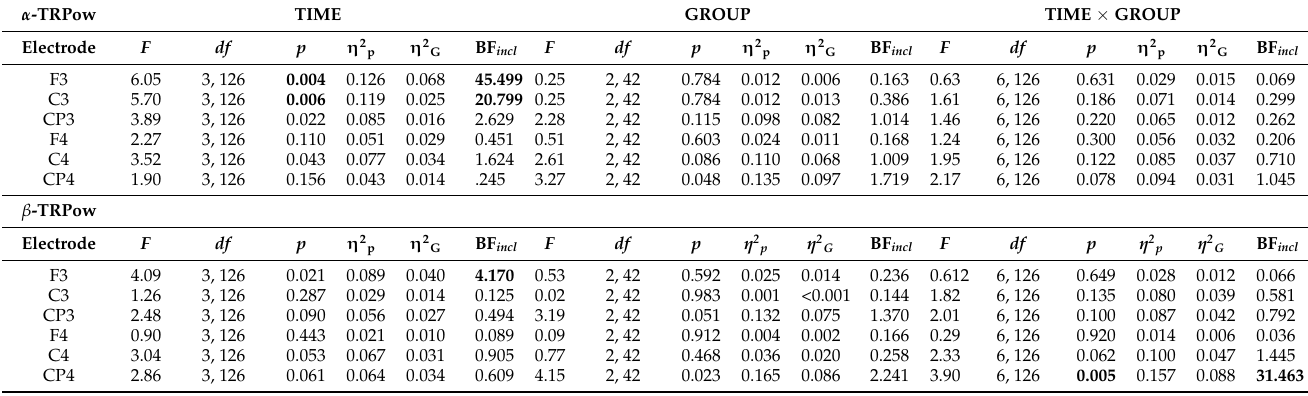
Table 4. F and Bayes statistics of the 3 × 4 RM-ANOVA of α -TRPow and β -TRPow for each electrode. Statistically significant effects (adjusted α = 0.008) and evidence in favor of the presence of an effect ( BF incl ) are marked in bold. α -TRPow TIME TIME × GROUP α Electrode